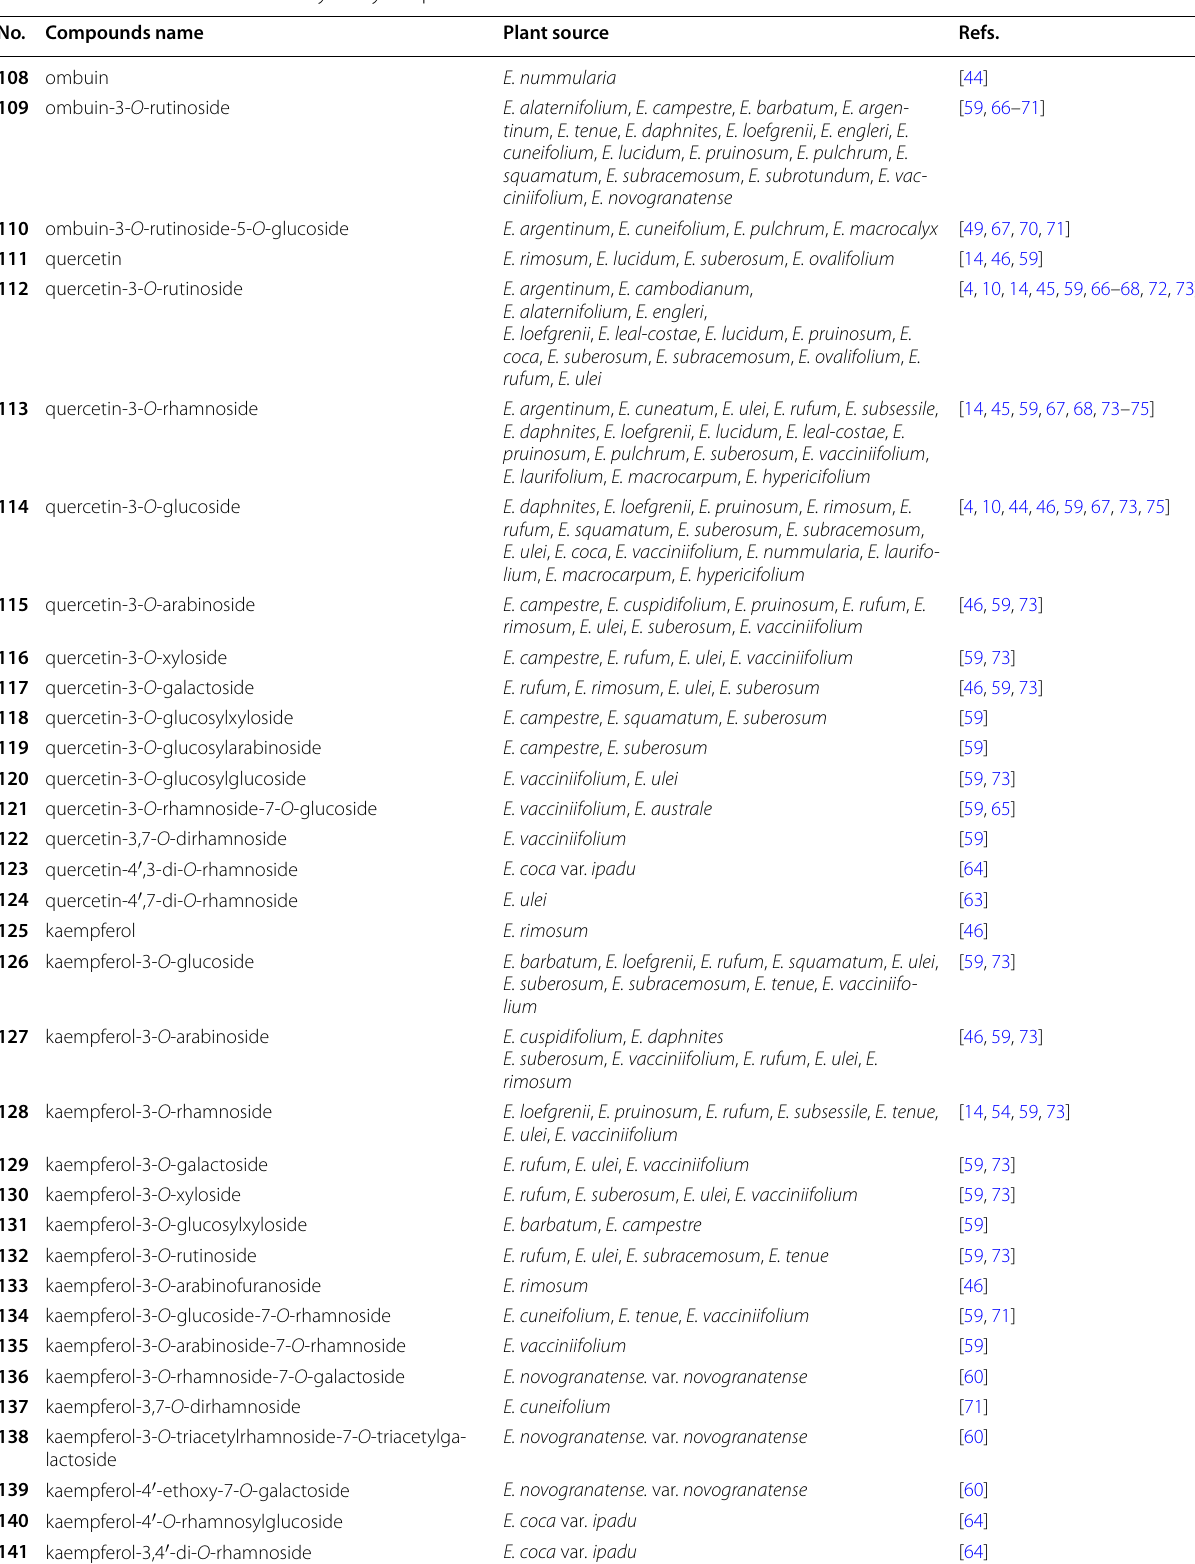
Table 7 Flavonoids isolated from Erythroxylum plants No. Compounds name Plant source